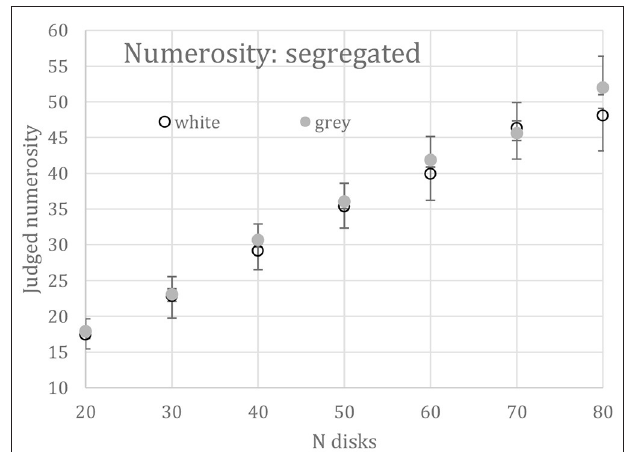
FIGURE 4 | Mean numerosity of segregated displays of 20 to 80 all white or all gray disks. Bars show 1 between-subjects SEs for the gray disks and + the white ones; confidence intervals are 28% larger than the